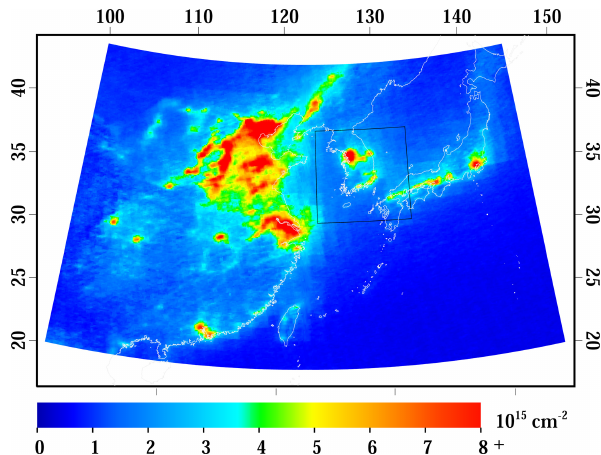
Figure 1. Warm-season averaged (May–September) NO 2 tropo- spheric vertical column content using the OMI-standard NO 2 prod- uct for the years 2015–2017 in East Asia. The 4km × 4km WRF- Chem domain is outlined over the Korean